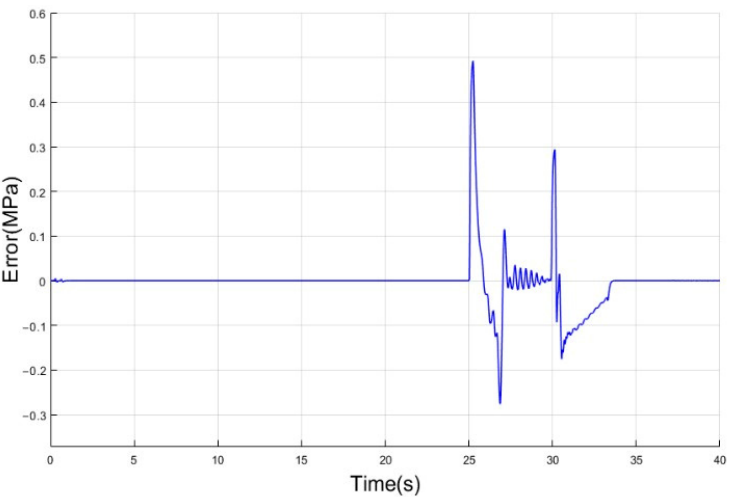
Figure 17. Pressure control error.